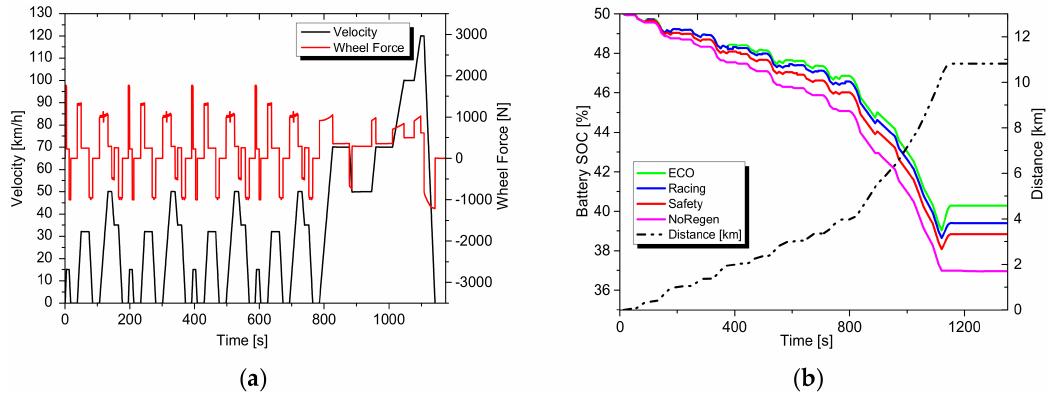
Figure 19. ( a ) Wheel horizontal braking force in NEDC; ( b ) economy simulation results for each